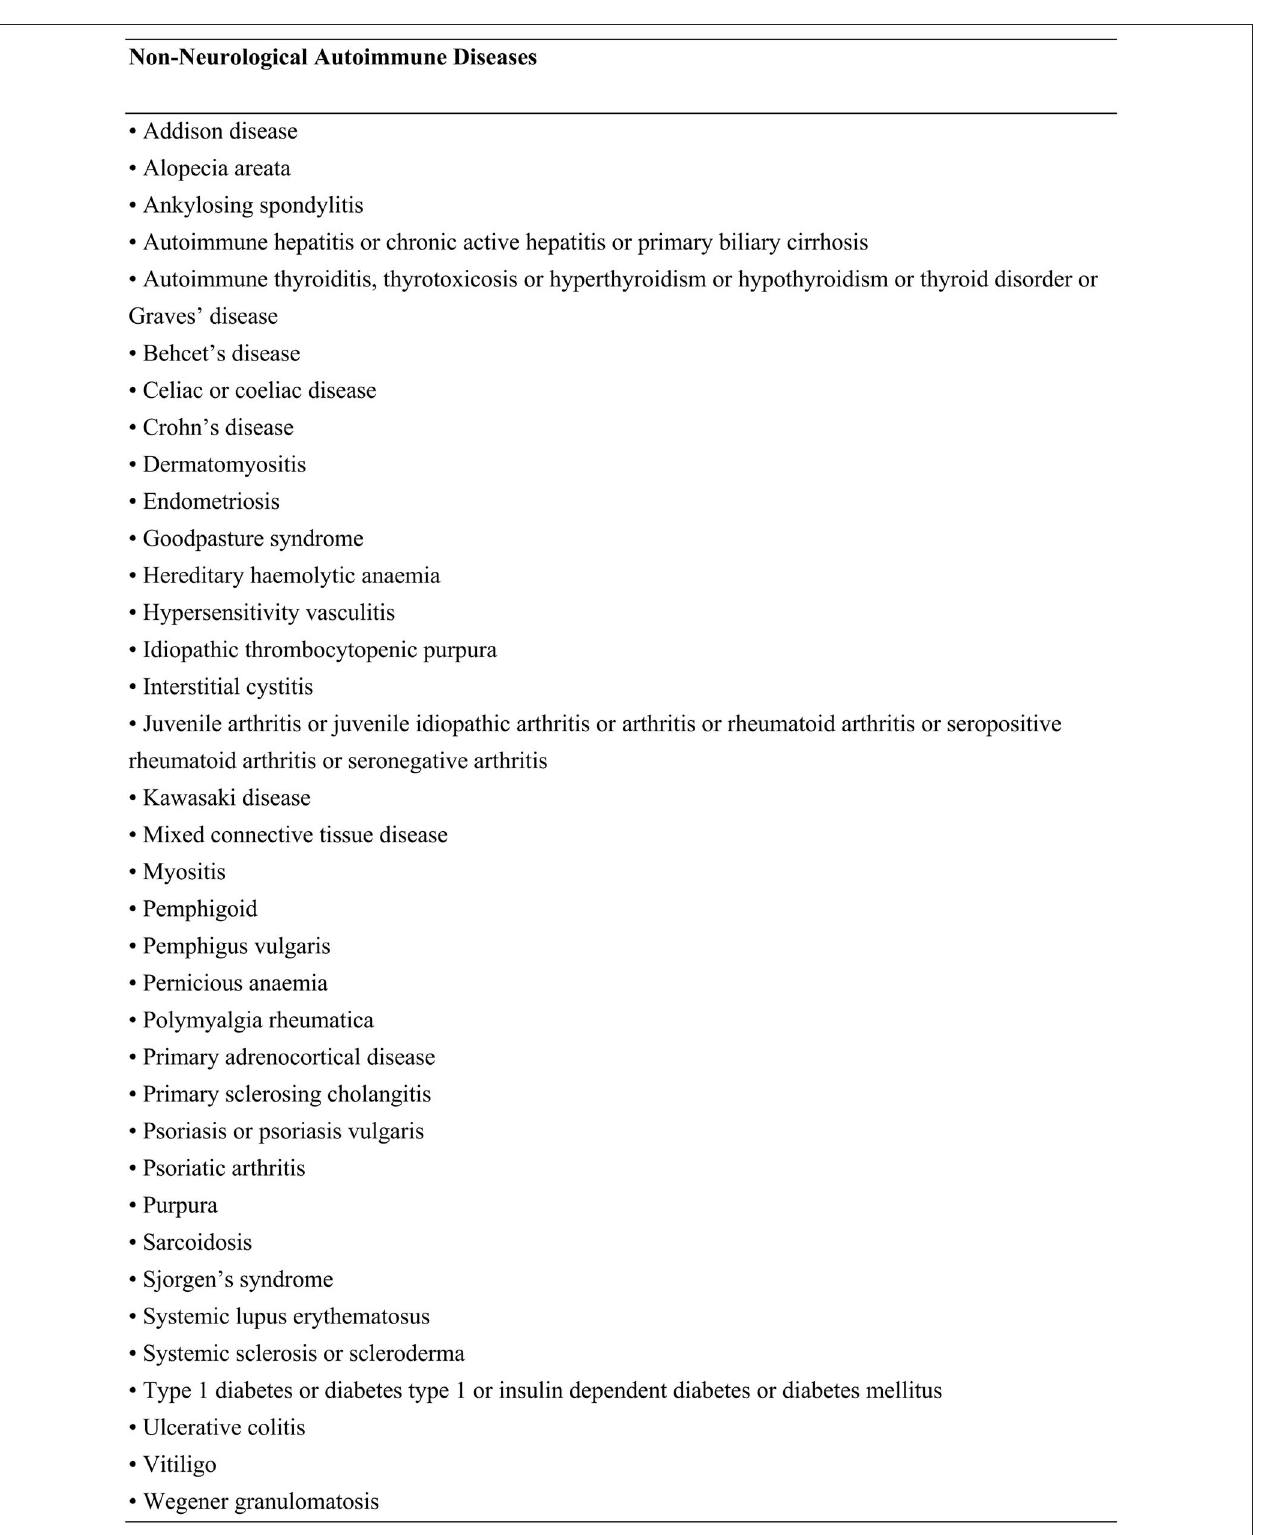
FIGURE 1 | Search terms used to identify non-neurological autoimmune diseases.